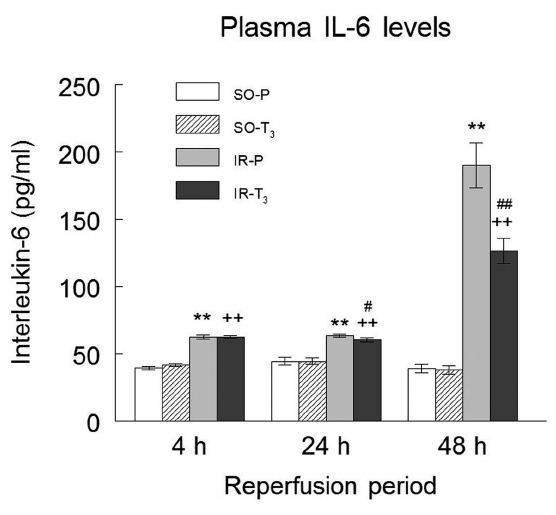
Figure 2. Plasma IL6 levels in the experimental groups. (n=10 each group): SO-P = sham-operated-placebo; SO-T 3 = sham-operated, T 3 -treated (100 m g/kg); IR-P= ischemia-reperfusion, placebo-treated; IR- T 3 = ischemia-reperfusion, T 3 -treated. Data are means 6 SEM. ** p , 0.001 versus SO-P group. ++ p , 0.001 versus SO-T 3 group. # p , 0.05,